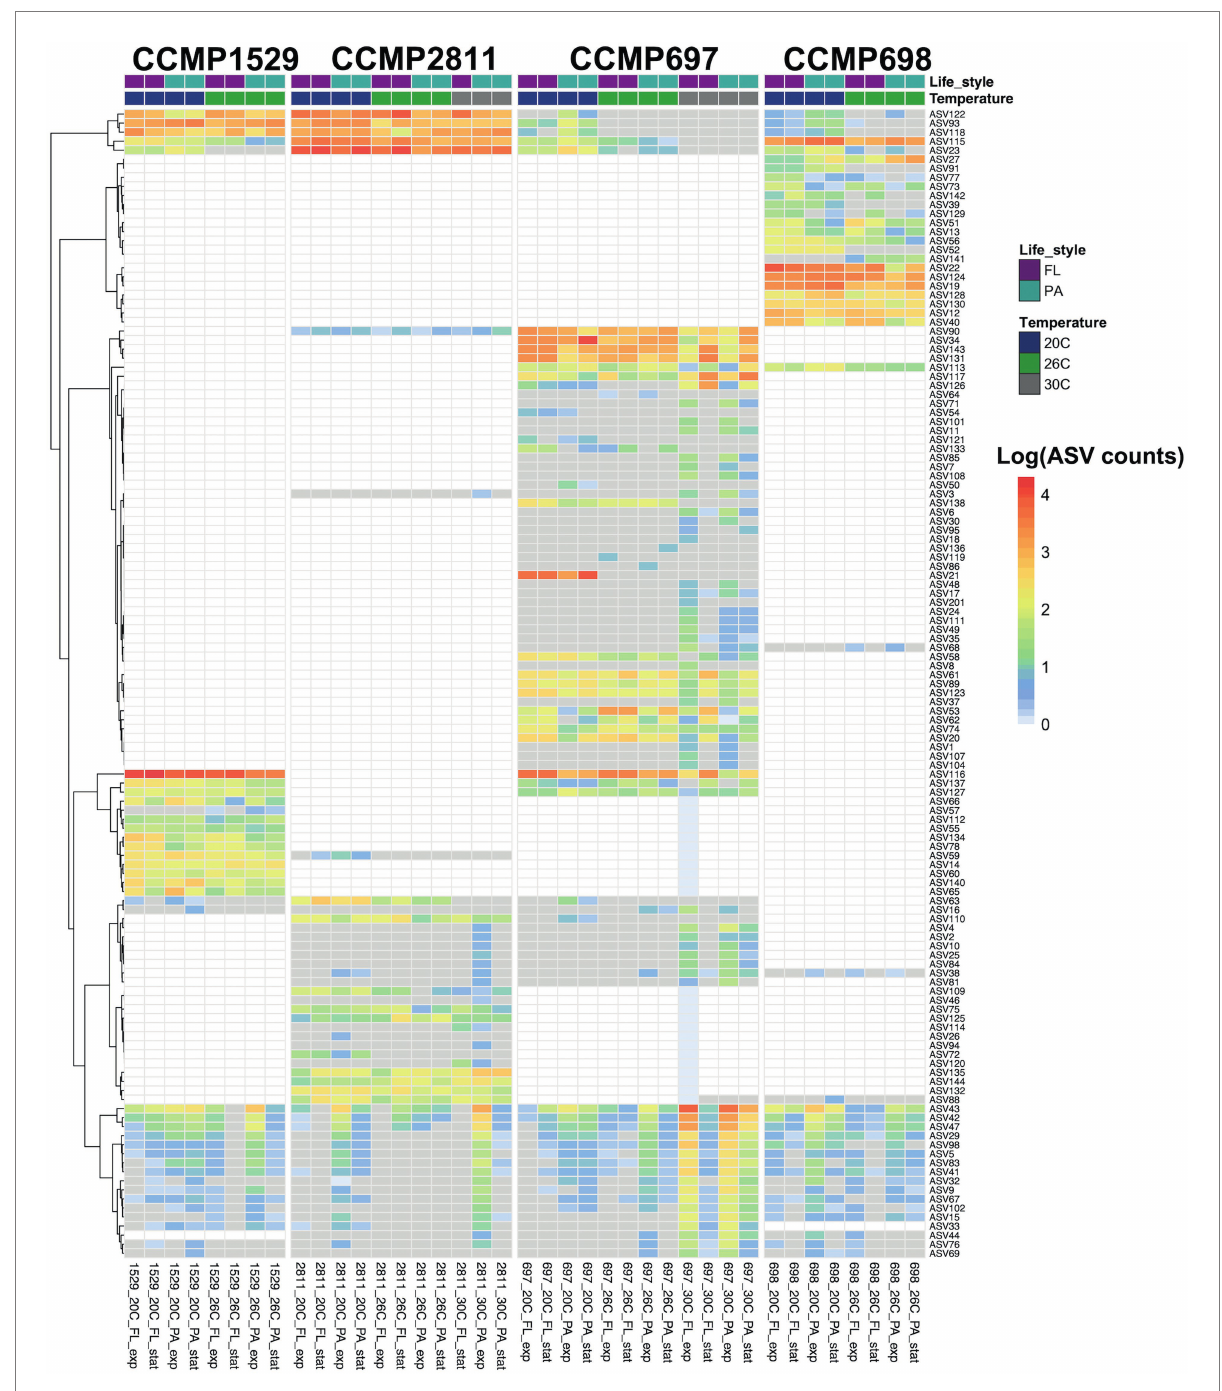
FIGURE 4 Abundance of all ASVs detected in four xenic strains of Prorocentrum cordatum . at different conditions and temperatures. The heatmap shows the hierarchical clustering of ASVs based on their abundances, expressed as log(1 + x). After AMCOM-II preprocessing, white squares correspond to “structural zeros” (lack of ASVs) and gray squares to “sampling zeros” (zeros due to abundance below detection limit/sequencing depth; Kaul et al., 2017). The average AVS abundance was calculated from two or three biological replicates for each strain at each condition, where the colors in the first row indicate lifestyle and the ones in the second-row temperature.